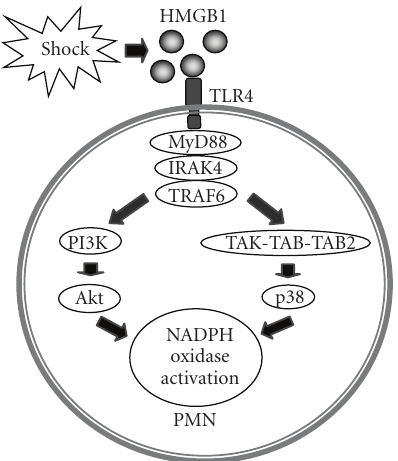
Figure 3: Model of HS-induced PMN NADPH oxidase activation. HMGB1 acts through TLR4 and MyD88-dependent signaling to mediate HS-induced NADPH oxidase activation. Akt and P38 MAP kinase are both involved in this